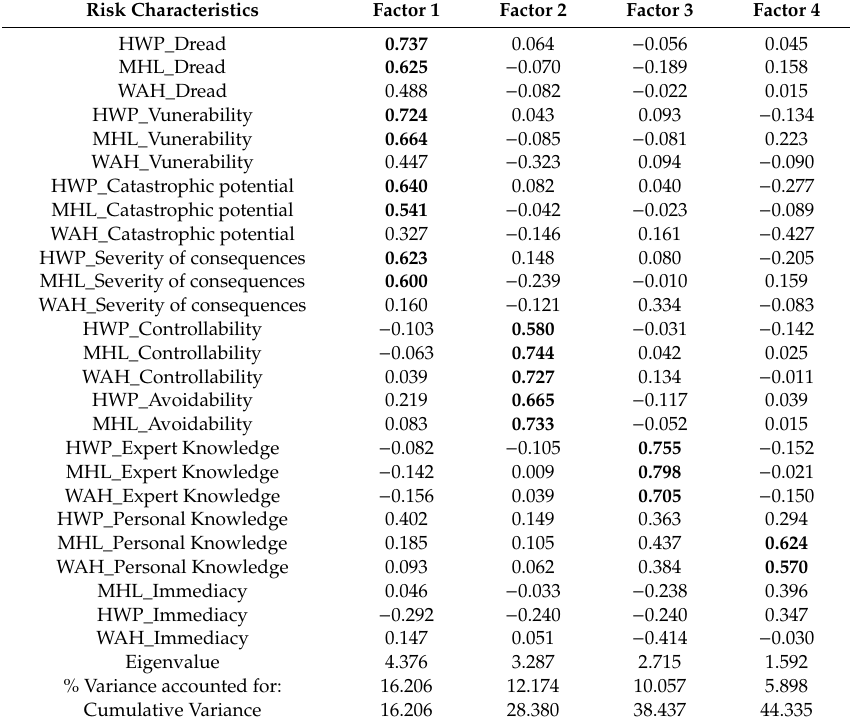
Figure 2. Profile of Mean Ratings for Qualitative Risk Characteristics. Figure 2 . Profile of Mean Ratings for Qualitative Risk Characteristics. Table 3. Risk Characteristics Factor Analysis Rotational Component Table 3. Risk Characteristics Factor Analysis Rotational Component Matrix.